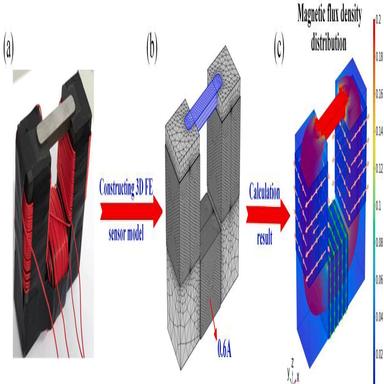
(a) The experimental sensor, (b) 3D FE modeling of the sensor, (c) the magnetic flux density distribution of the sensor model when the relative permeability of the test sample is 316.